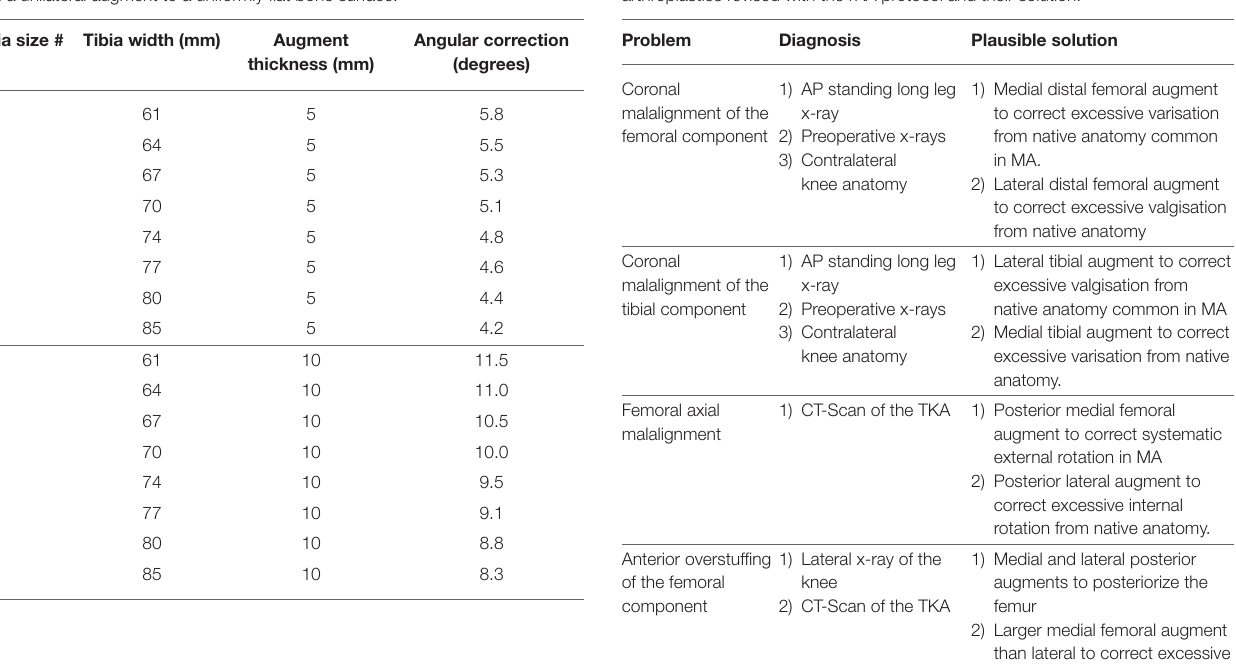
TABLE 2 | Estimated angular correction given by apposing a femoral component with a unilateral augment to a uniformly flat bone surface. Femur size # Femur width (mm)